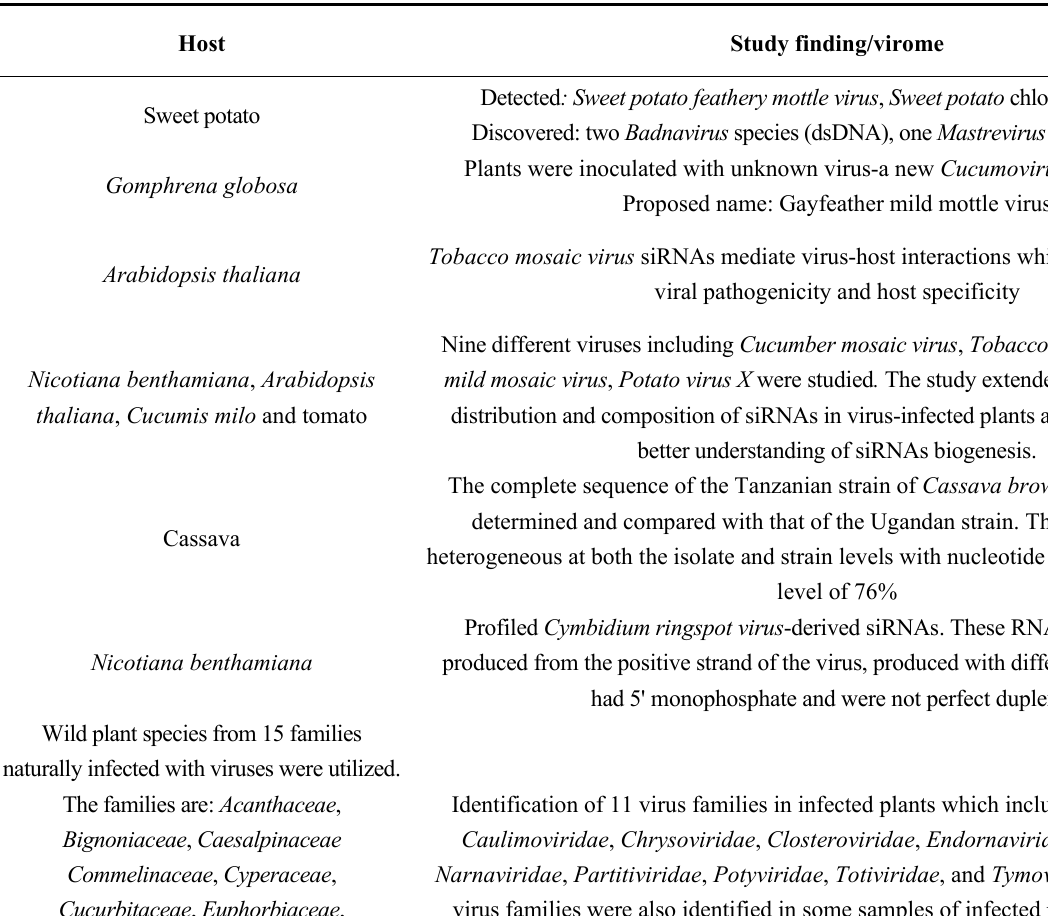
Table 3. Next-generation sequencing of plant viral siRNA, RNA or DNA from virus infected herbaceous, grass, fiber- producing, or vine hosts. Host Discovered: two Badnavirus species (dsDNA), one Mastrevirus species (ssDNA) Plants were inoculated with unknown virus-a new Cucumovirus was